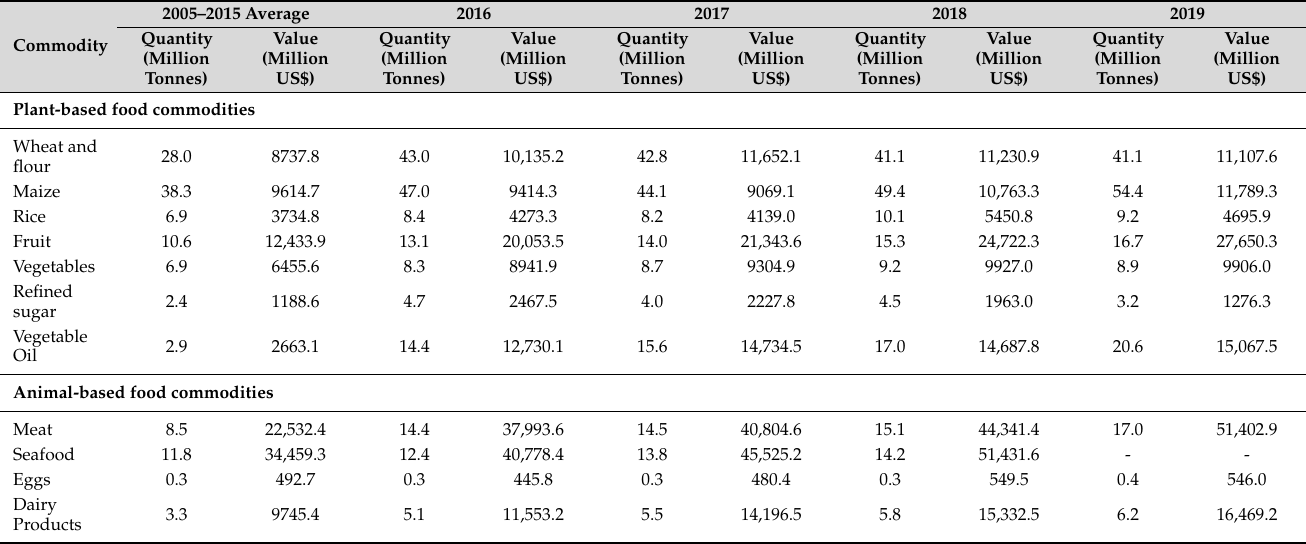
Table 4. Major food commodity imports in East and Southeast